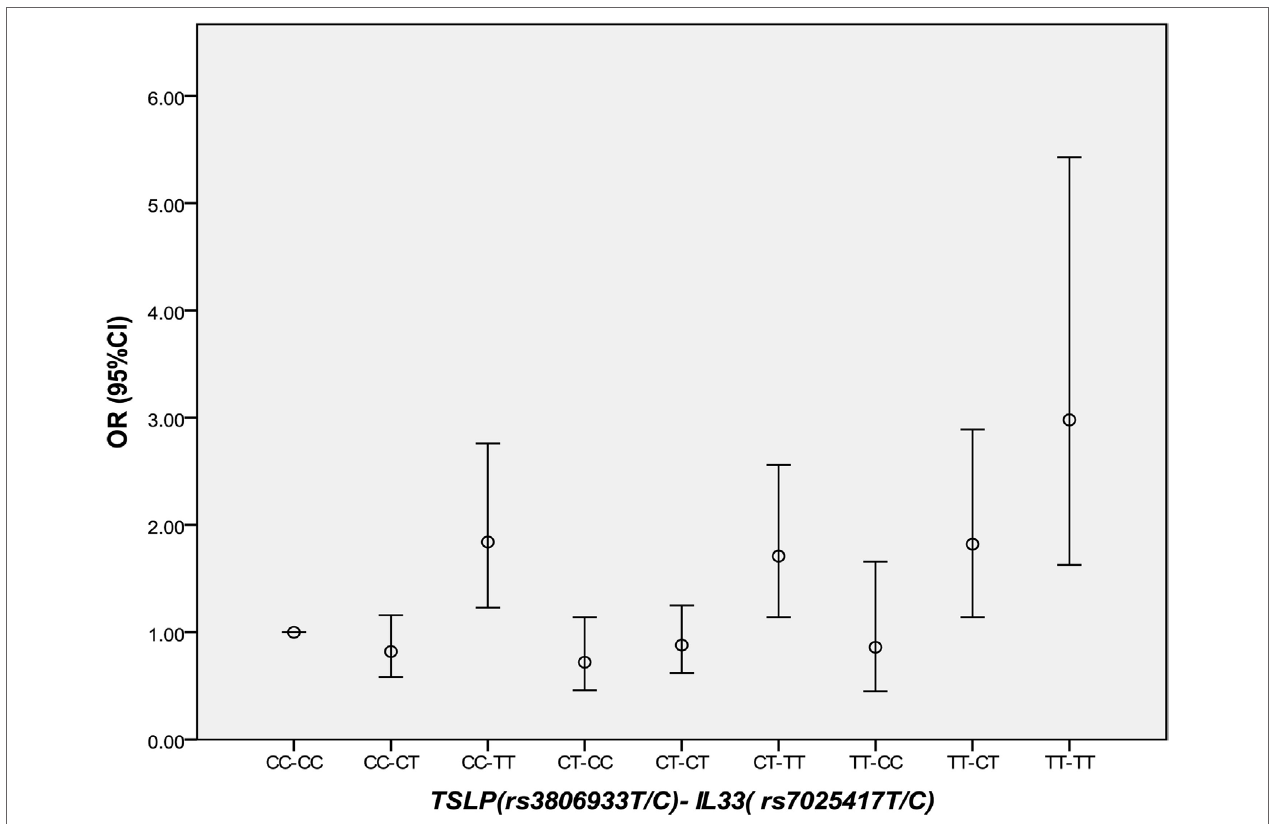
FigUre 4 | Comparison of odds ratio (OR) values for the interaction analysis between rs3806933 in thymic stromal lymphopoietin ( TSLP ) and rs7025417 in IL33. OR values with a 95% confidence interval (CI) for the combinations under the genotypic